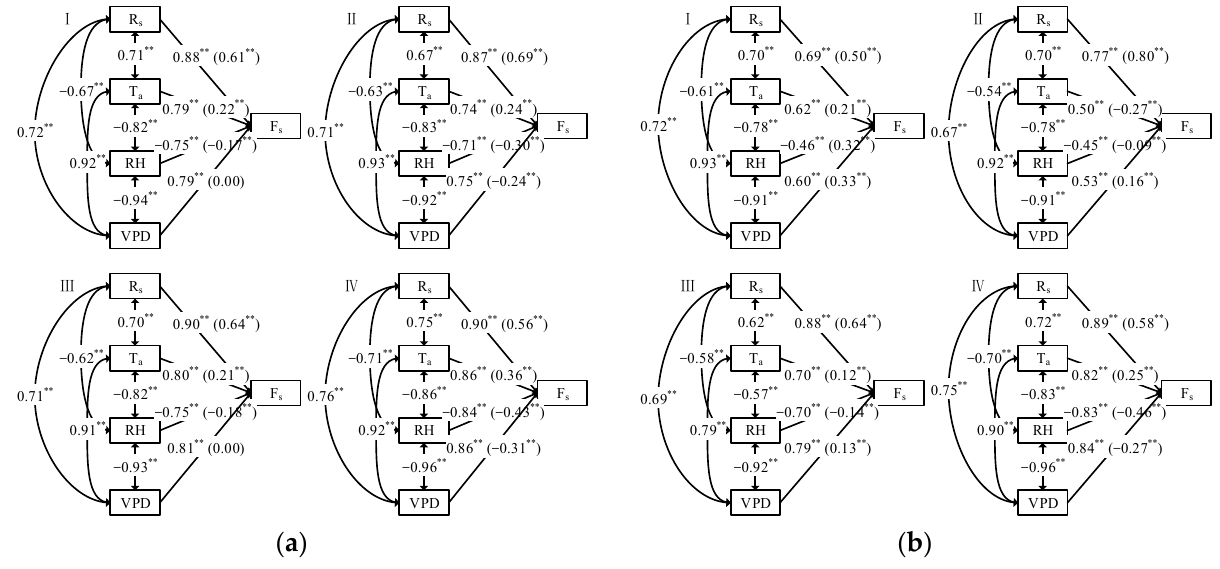
Figure 5. Path analysis results of instantaneous transpiration and meteorological factors in each growth period. ( a ) 2020; ( b ) 2021. I, II, III, and IV respectively represent the new growth period, flowering and fruit setting period, fruit expansion period, and fruit maturation period. * Indicates significant correlation between independent variable and dependent variable ( p < 0.05); ** Indicates highly significant correlation between independent variables and dependent variables ( p < 0.01).